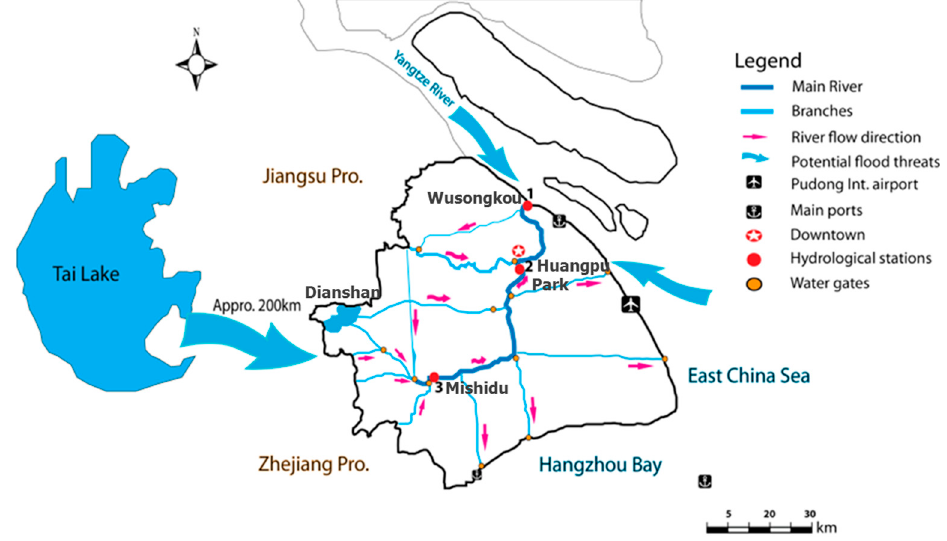
Figure 1. Water system of Shanghai. Table 1. Crest height, design water level, warning water level, and historical records at hydrological stations (Wusongkou, Huangpu Park and Mishidu) for Huangpu River.